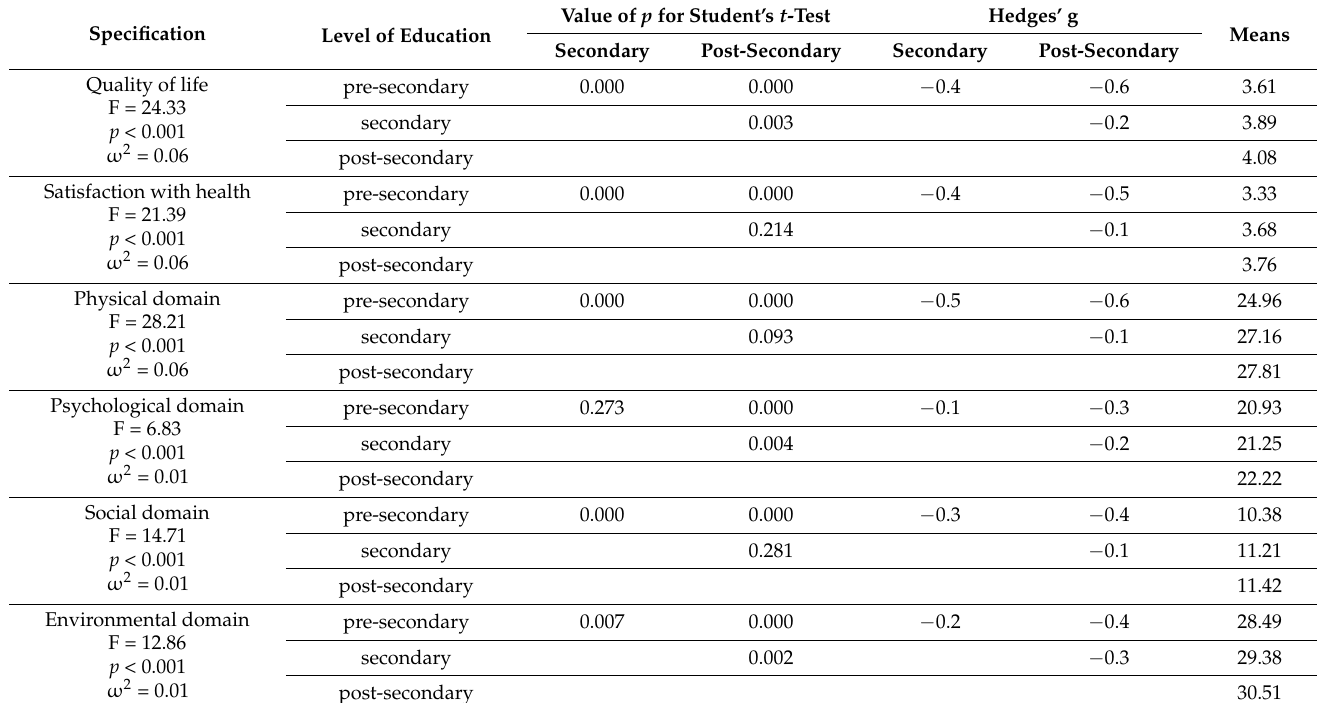
Table 4. Education and quality of life of students, their parents, and their grandparents (F-test, ω 2 , t -test, Hedges’